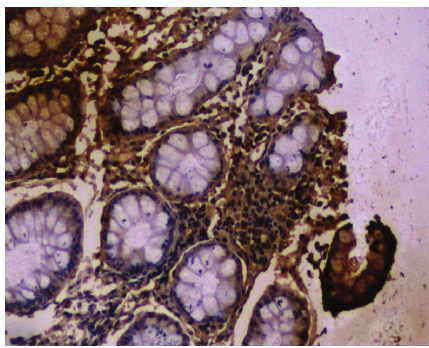
Figure 5: Positive particle for anti-IgA (1 ×